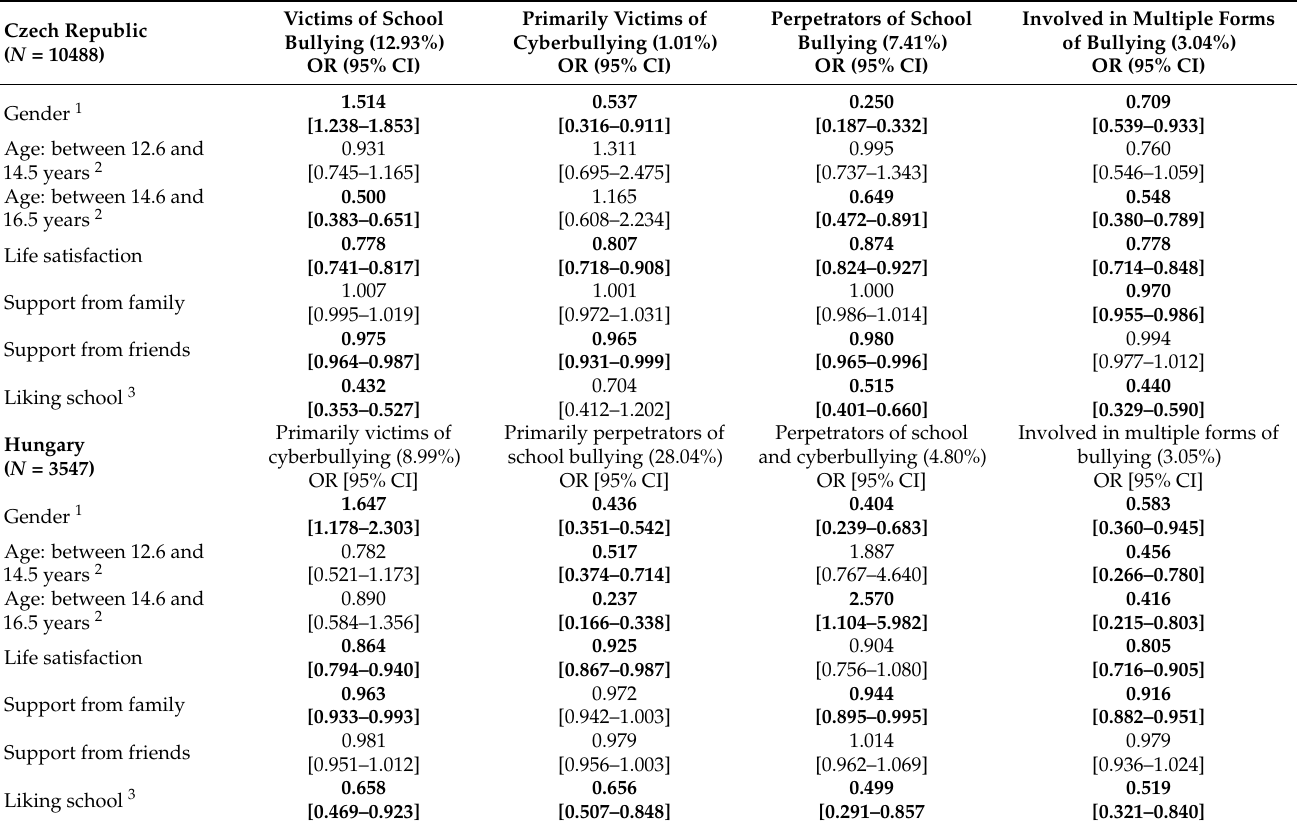
Table 5. Multinomial logistic regression analyses in each country to examine predictors of the latent